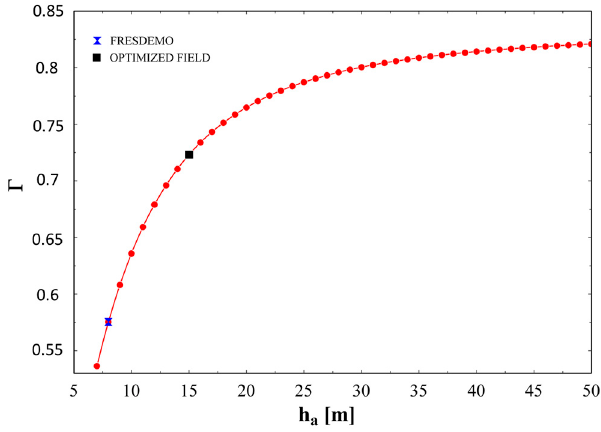
Figure 9. Intercept factor as a function of receiver height.